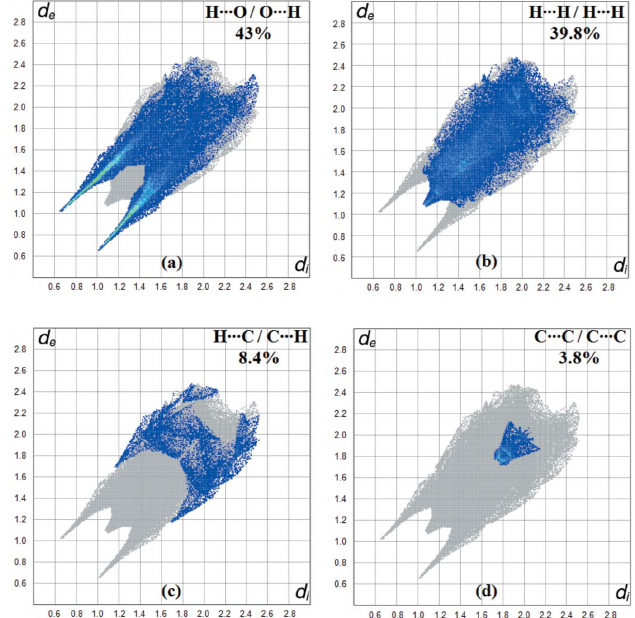
Figure 6 ( a ) H (cid:2)(cid:2)(cid:2) O/O (cid:2)(cid:2)(cid:2) H, ( b ) H (cid:2)(cid:2)(cid:2) H/H (cid:2)(cid:2)(cid:2) H, ( c ) H (cid:2)(cid:2)(cid:2) C/C (cid:2)(cid:2)(cid:2) H and ( d ) C (cid:2)(cid:2)(cid:2) C/ C (cid:2)(cid:2)(cid:2) C contacts in the title complex, showing the percentages of contacts contributing to the total Hirshfeld surface area.